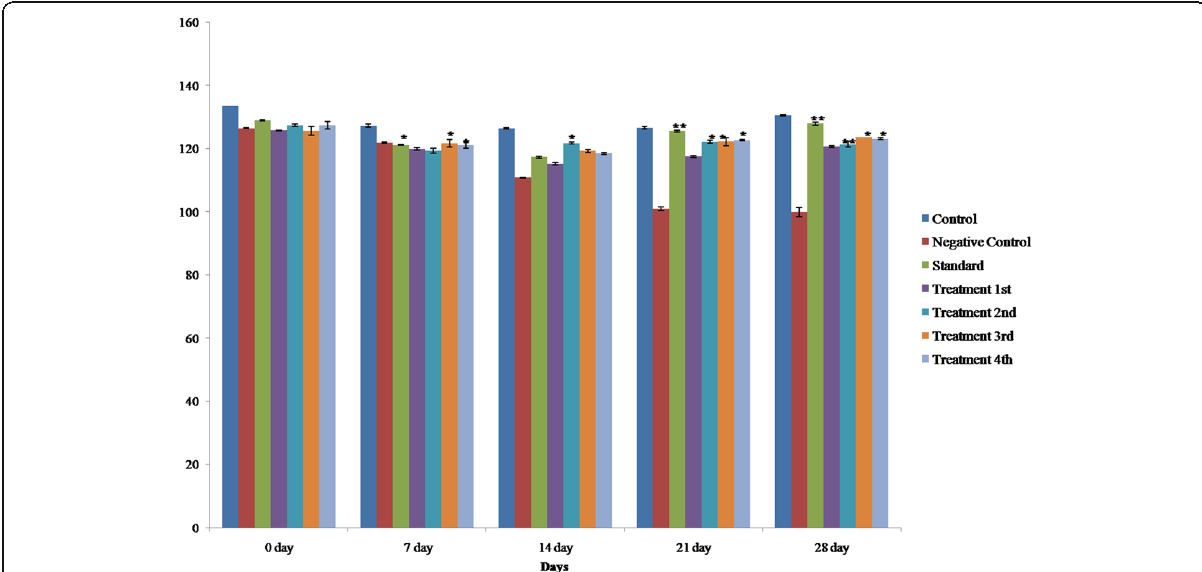
Fig. 6 Effect of PH extracts on Locomotor Activity. Results are Mean ± S.E.M, n = 6 animals in each group. ANOVA, Dunnett ’ s test ** p < 0.001,* p